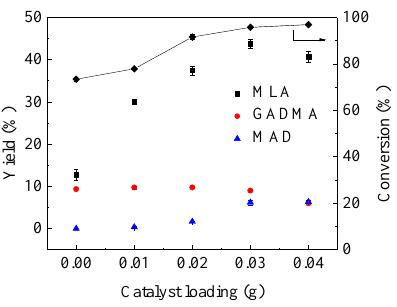
Figure 4. Effect of the c-Co 0.25 loading on the conversion of HFCS-55. Reaction conditions: HFCS-55, 0.06 g; methanol, 6 mL; 180 °C; 18 h. 0.06 g; methanol, 6 mL; 180 ◦ C; 18